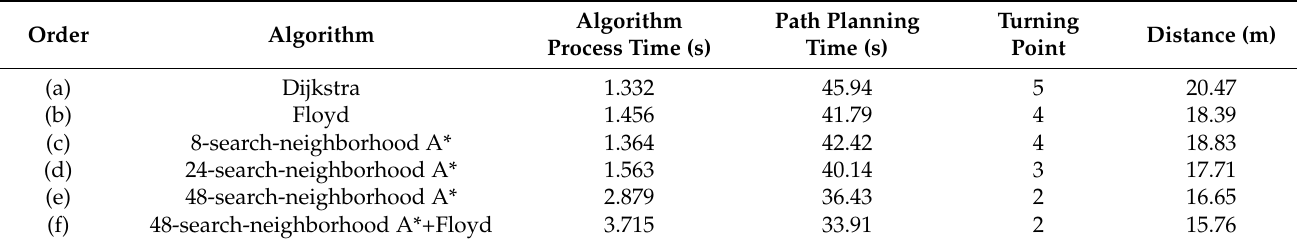
Table 1. Simulation comparison of different algorithms for path planning.